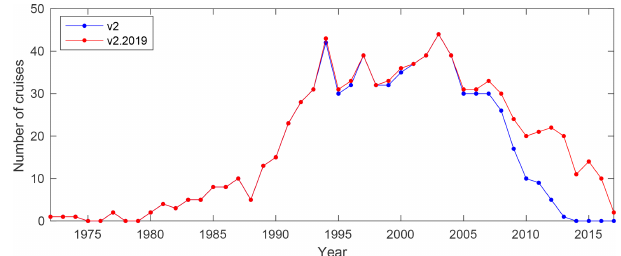
Table 3. Initial minimum adjustment